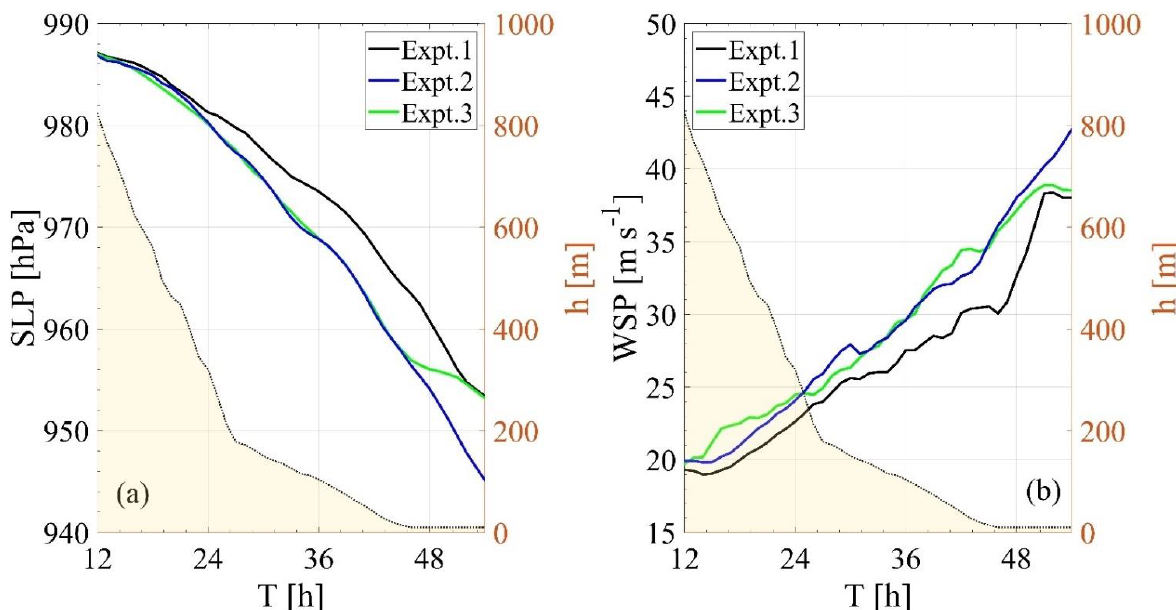
Figure 5. ( a ) The minimum sea level pressure (SLP) varies with the simulation time for the Expt.1, Expt.2, and Expt.3, respectively. ( b ) same as ( a ), but for the maximum 10 m wind speed (WSP). In each plot, the border of the shadow area indicates the local water depth around the TC center of Expt.1.